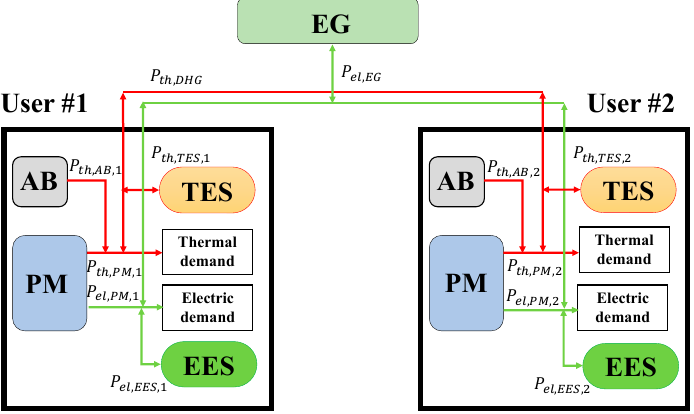
Figure 1. Reference scenario.